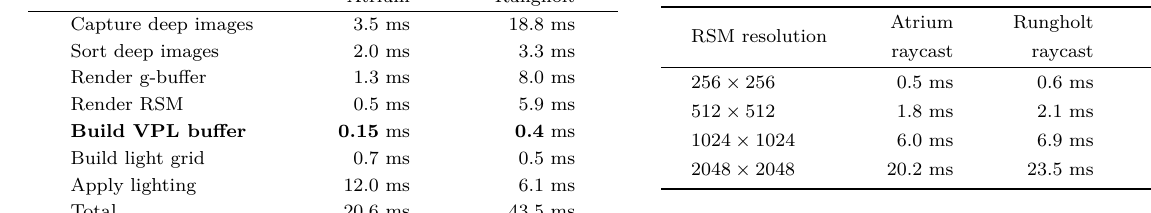
Table 1 Time for each step of VPL rendering Table 3 Raycasting time for Atrium and Rungholt scenes, versus assigning random size